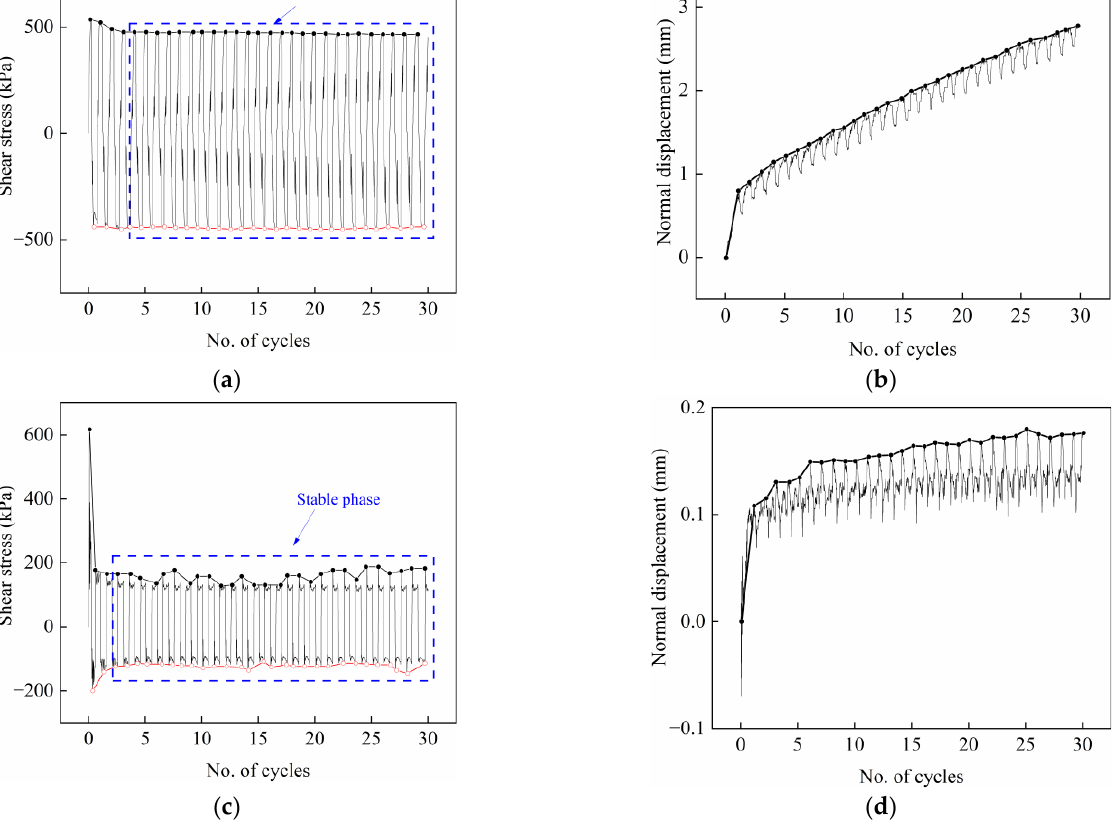
Figure 4. Typical variation of the shear stress and normal displacement with the number of cycles for frozen cement-treated sand – concrete interface. ( a ) Shear stress at − 1 °C, 700 kPa; ( b ) normal for frozen cement-treated sand–concrete interface. ( a ) Shear stress at − 1 ◦ C, 700 kPa; ( b ) normal displacement at −1 °C, 700 kPa; ( c ) shear stress at −14 °C, 700 kPa; ( d ) normal displacement at −14 °C, displacement at − 1 ◦ C, 700 kPa; ( c ) shear stress at − 14 ◦ C, 700 kPa; ( d ) normal displacement at 700 kPa. − 14 ◦ C, 700